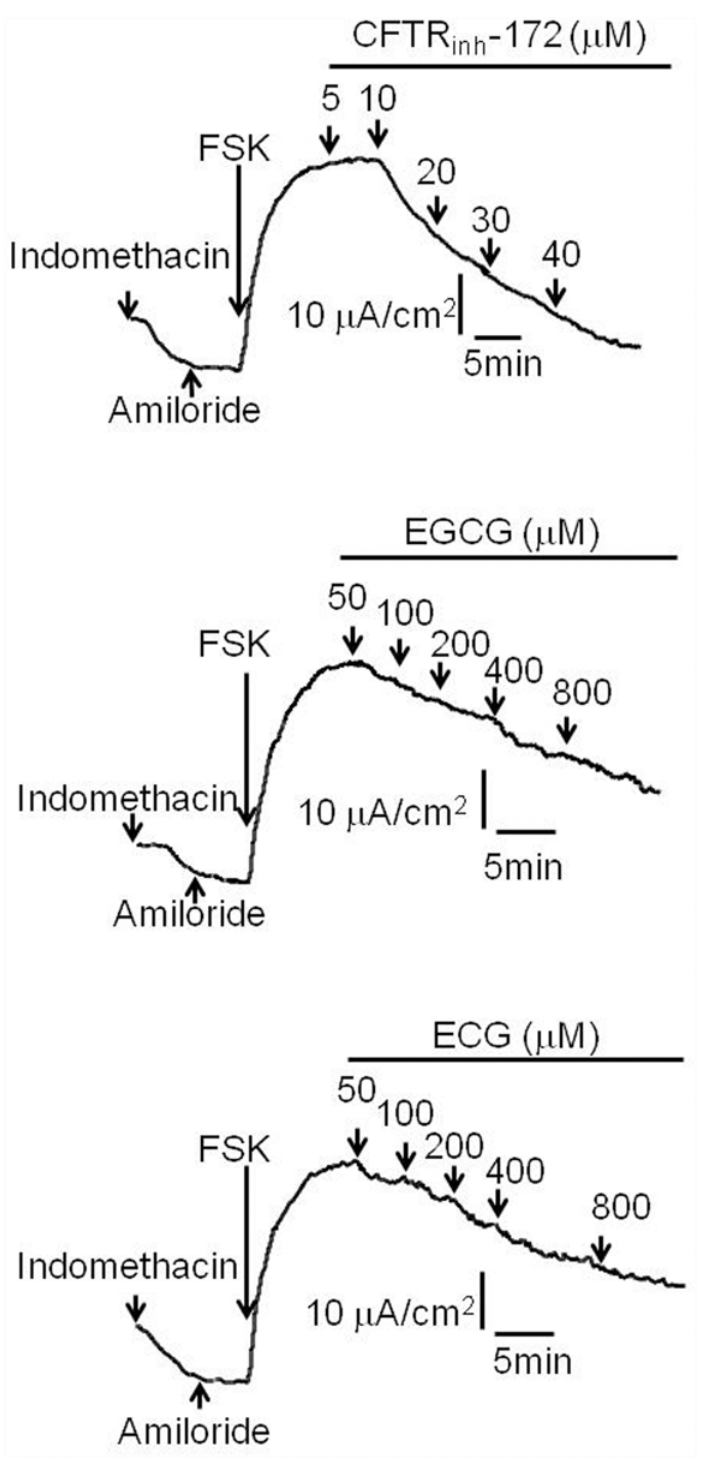
Fig 5. CFTR inhibition by EGCG and ECG. A. Dose — response relationship of EGCG and ECG determined in the iodide influx assay. Data were expressed as mean ± SE, n = 3). B. EGCG and ECG inhibition short- circuit current after amiloride and indomethacin addition and stimulation by FSK (20 μ M) in isolated rat colonic mucosa. EGCG and ECG were added to mucosal surfaces as indicated. One experiment typical of four or five is